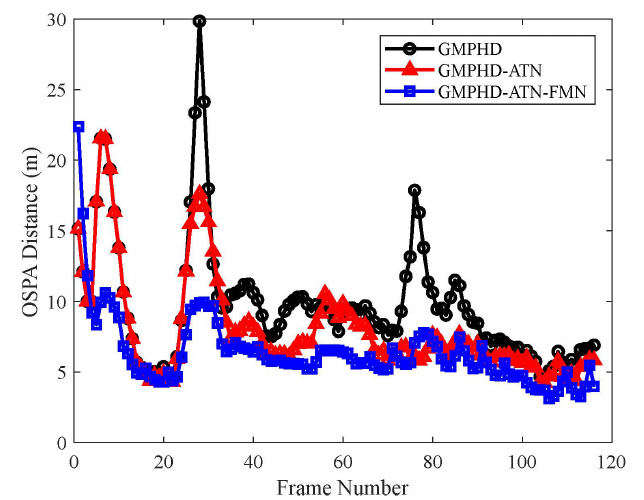
Figure 9. OSPA distance comparison.